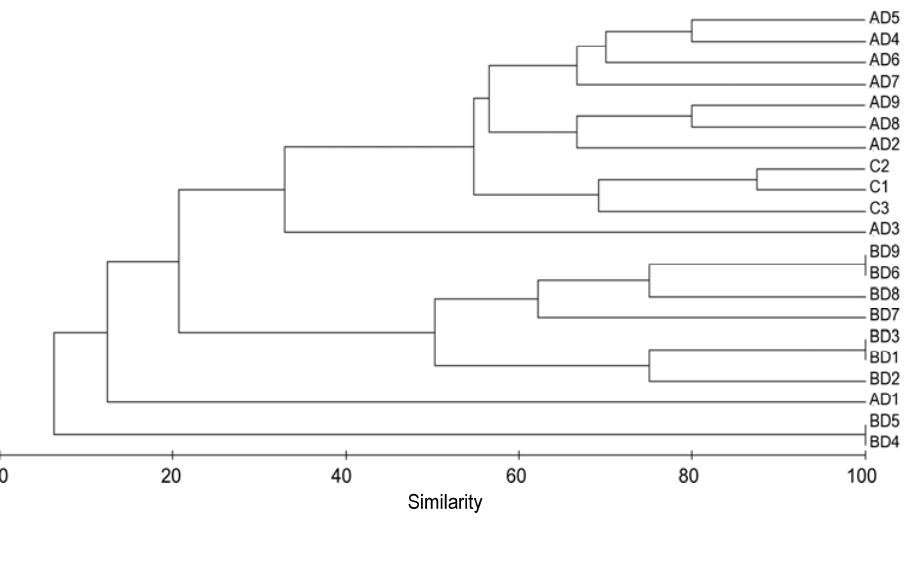
Figure 4. Dendrogram showing clustering of sites: above-dam (AD), below-dam (BD), and control